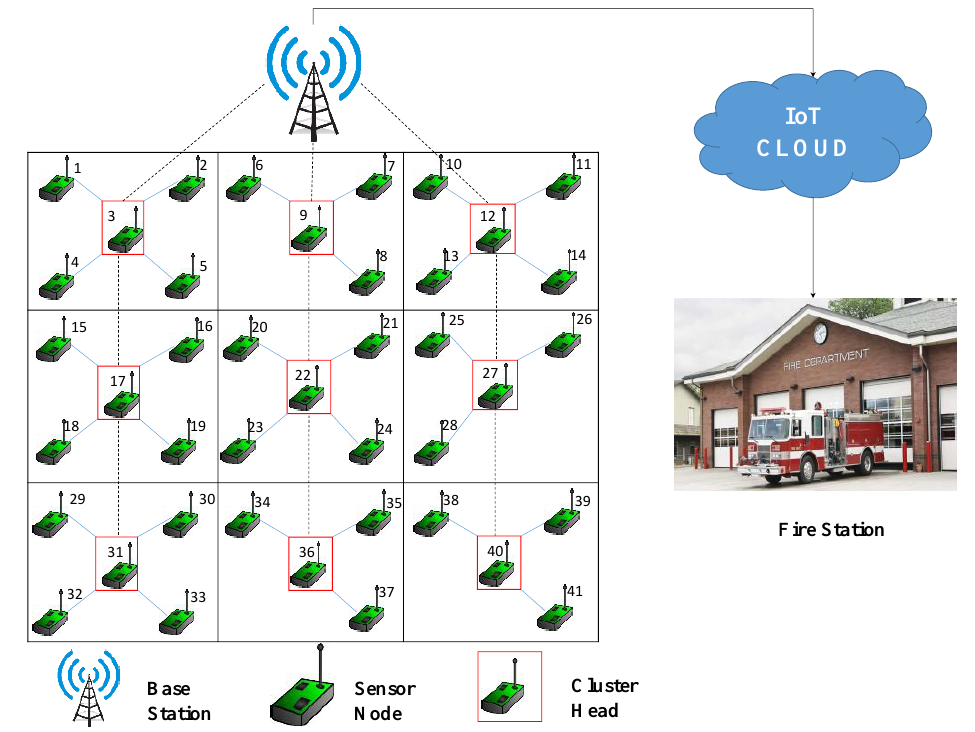
Figure 1. The network architecture in the Proposed Model. A frame is divided into two parts, namely intra-cluster communication period and inter-cluster communication period. In the intra-cluster communication period, sensor nodes send data to their CHs in the allocated time slots. In the inter-cluster communica- tion period, a CH sends data to its upstream CH or the BS. The frame size is determined by the BS. A sample frame structure is shown in Figure 2. The frame structure is related to the network presented in Figure 1. The number of ordinary nodes in the largest cluster determines the number of slots in the intra-cluster communication period. The number of slots in the inter-cluster communication period depends on the number of clusters in a column and the number of clusters in a row in the network architecture. In the frame Figure 2. Intra-cluster and Inter-cluster communication periods in a frame. shown in Figure 2, there are four slots in the intra-cluster communication period and five slots in the inter-cluster communication period.